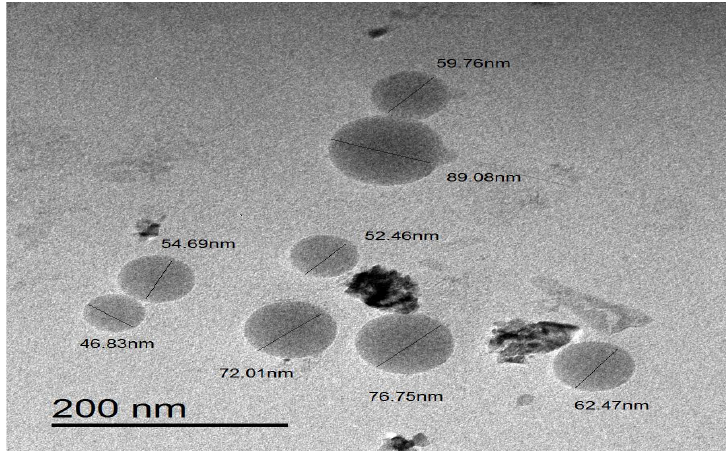
Figure 4. The transmission electron microscopy image of NEF#4.